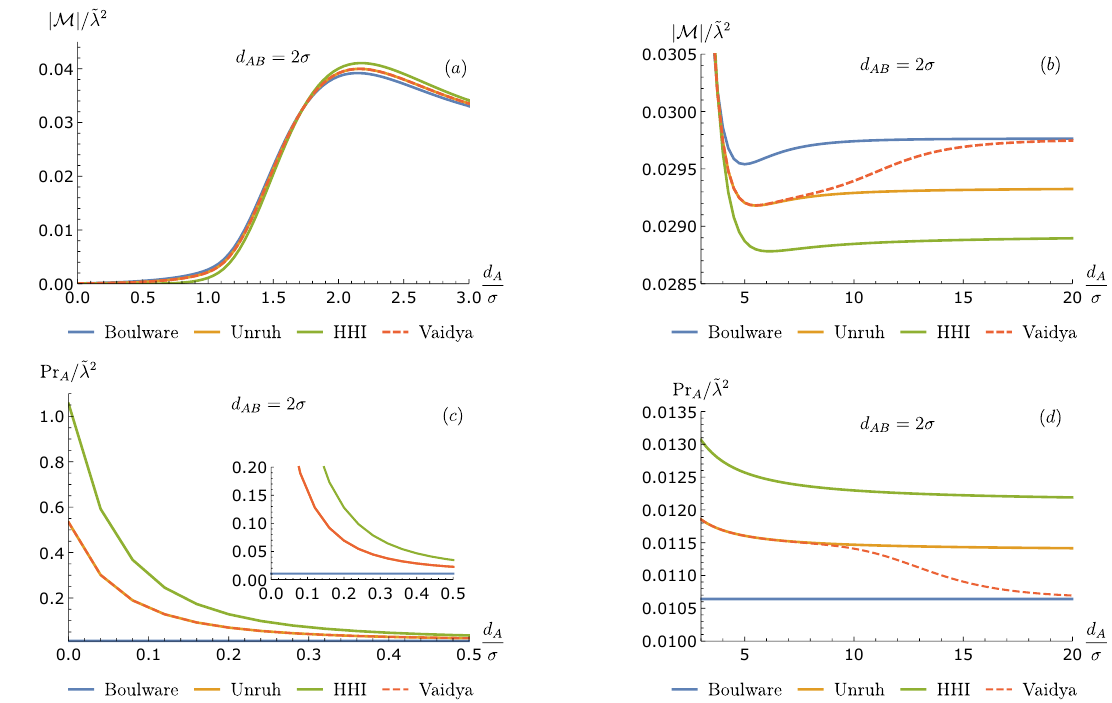
Figure 4 . The nonlocal contribution M and excitation probability of detector A, Pr A (cid:17) L AA , as a function of proper distance of detector A away from the horizon (in units of (cid:27) ) for various choice of vacua. Here ~ (cid:21) = (cid:21)(cid:27) 1 (cid:0) n 2 = (cid:21) is dimensionless coupling constant. We set (cid:10) (cid:27) = 2, M=(cid:27) = 1 d ( r A ; r B ) = 2 (cid:27) . The detectors are turned on at (cid:28) 0 = 12 (cid:27) so that the Gaussian switching peak is very far from the shell. (a) the nonlocal term M . (a) and (c): near the horizon. (b) and (d): far from the